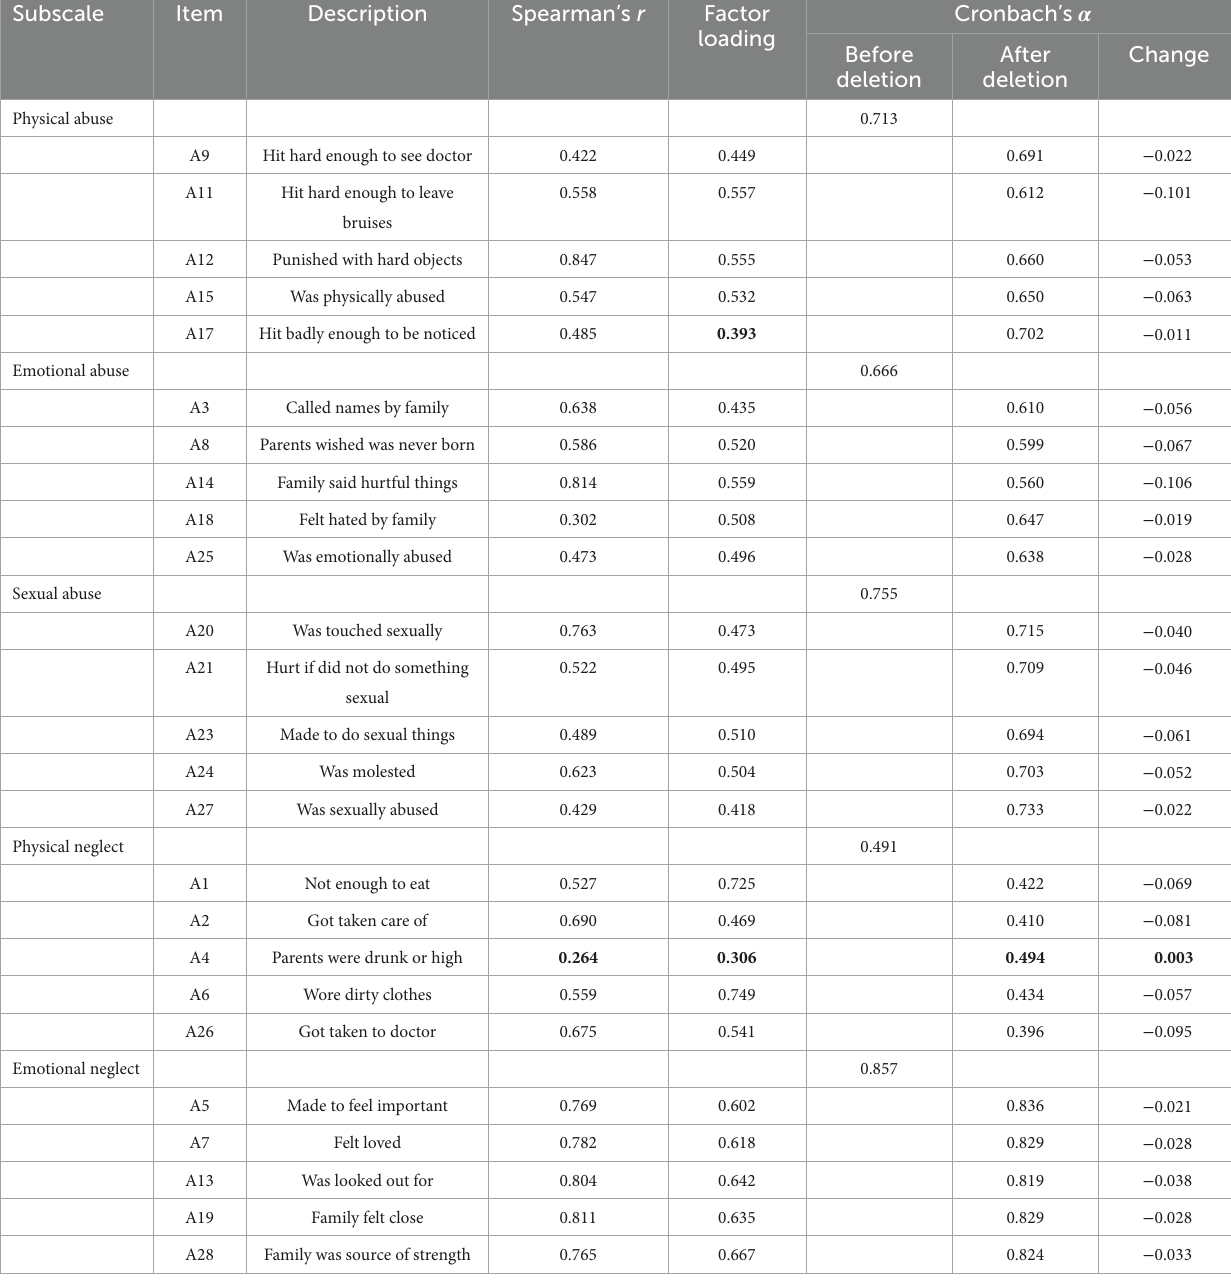
TABLE 2 Results of Item analysis for 25 clinical items from the original